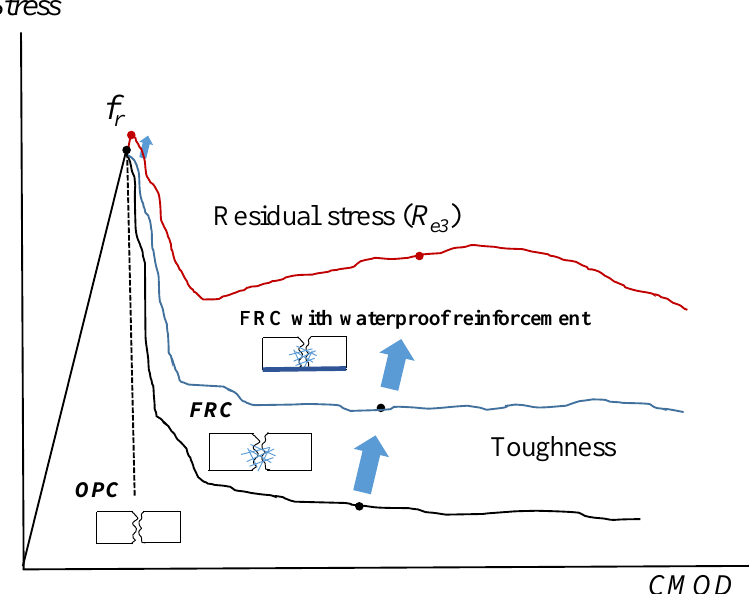
Figure 13. Comparison for residual stress between fiber addition and OPC.